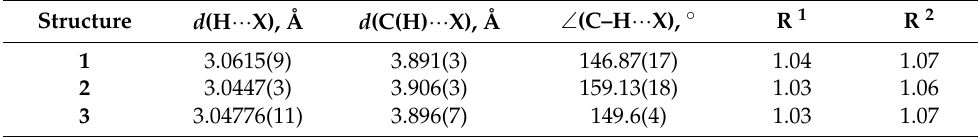
Table 3. Characteristic parameters of C–H ··· X–C hydrogen bonds in 1 – 3 .